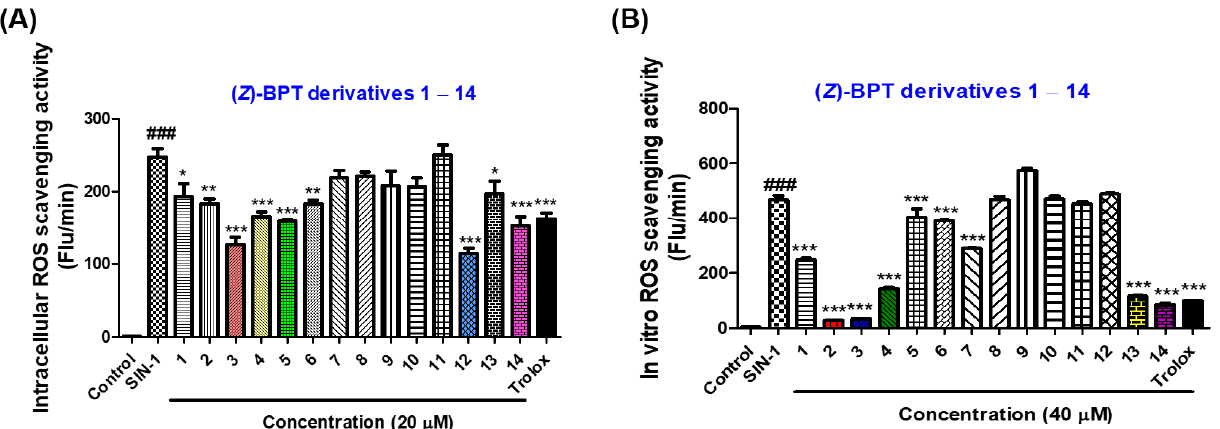
Figure 10. The radical scavenging effect of ( Z )-BPT derivatives on DPPH. The DPPH radical scavenging activities of test samples (1 mM) were assayed after being left in the dark for 30 min. Distilled water and dimethyl sulfoxide (DMSO) were utilized as the solvents for the positive control L -ascorbic acid and the ( Z )-BPT derivatives, respectively. Asterisks (***) represent a significant difference be- tween L -ascorbic acid and the ( Z )-BPT derivatives, and results are expressed as the mean ± standard error of three different experiments. *** p < 0.001.